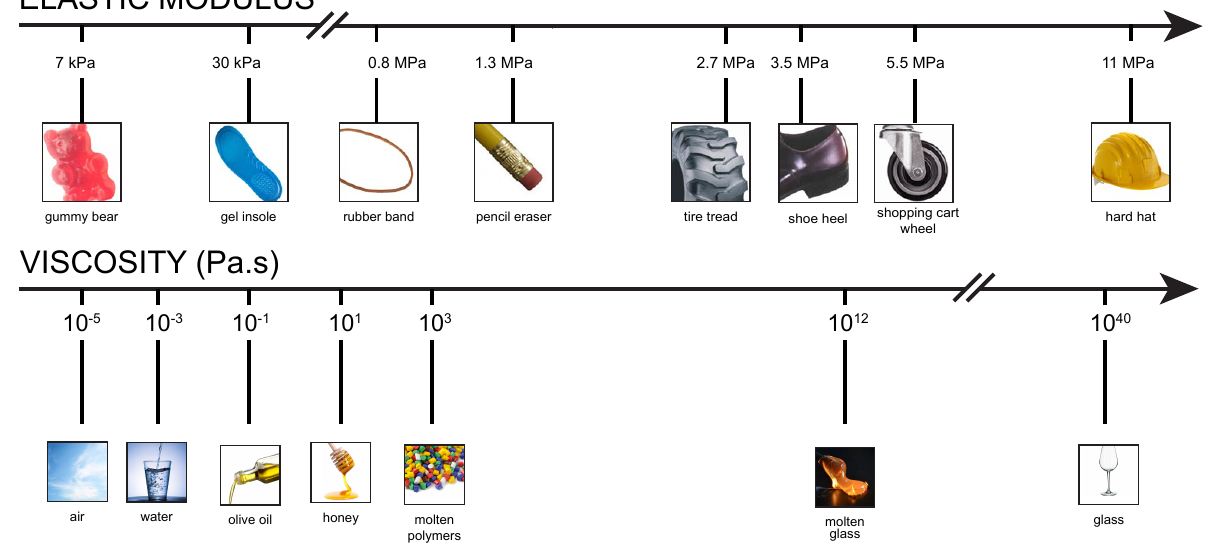
Figure 1: Simple solids and Newtonian fluids can be easily described by single-valued material properties, such as a Young’s modulus or a Newtonian viscosity [6]. This enables easy intuition when designing with these materials as well as easy communication of the material properties. Figure adapted from [6], [7] and [8].